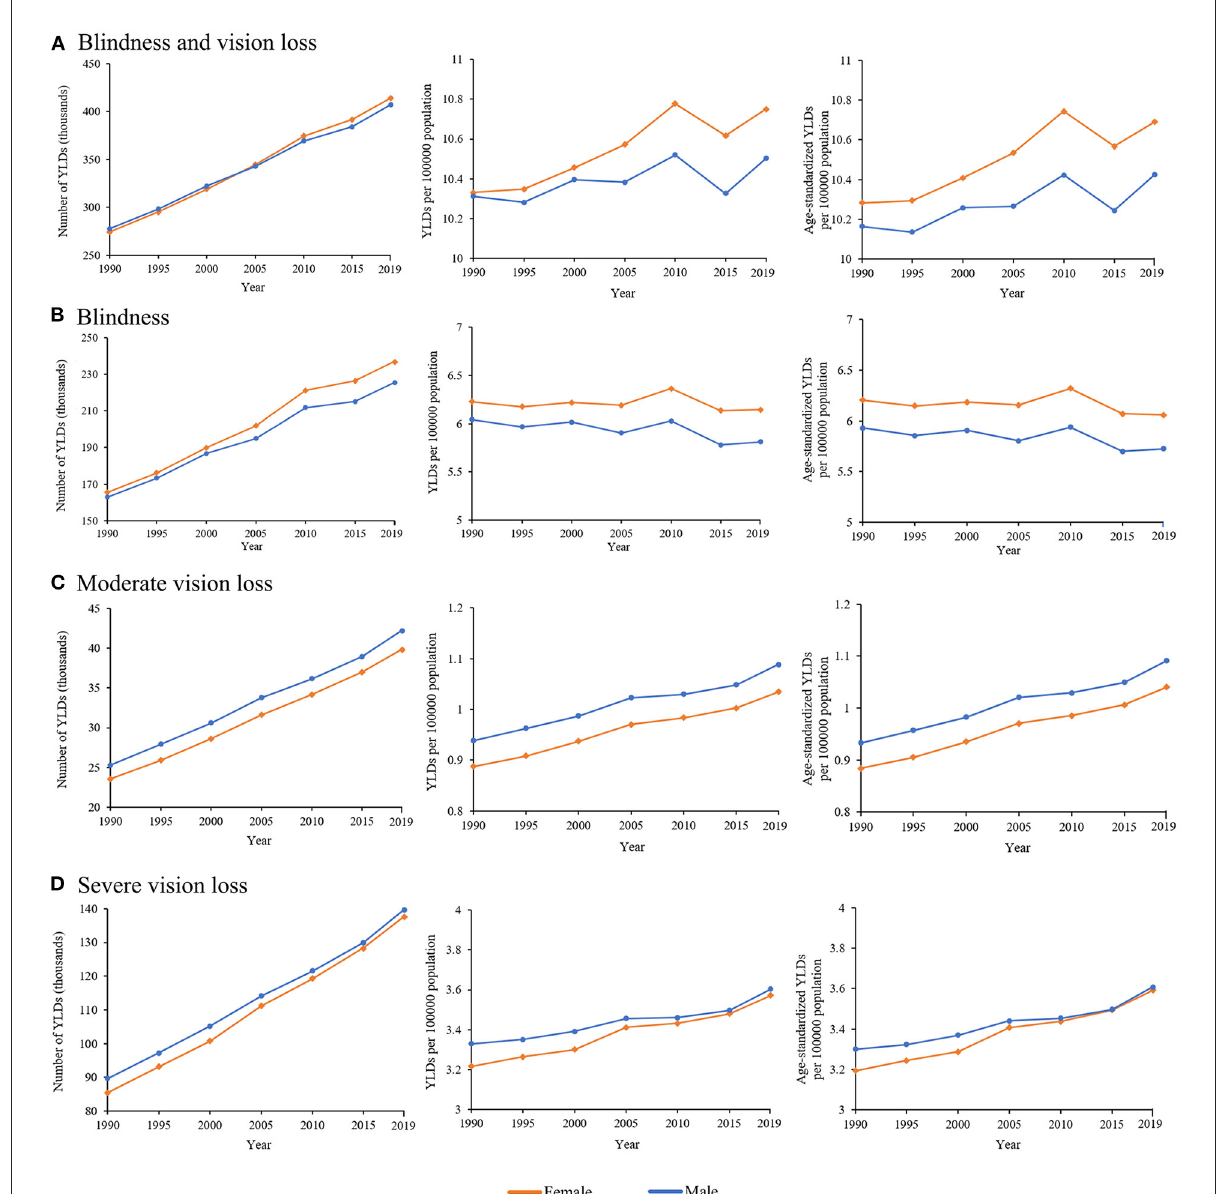
FIGURE1 Global sex-specific burden of vision impairment associated with NPB from 1990 to 2019. (A) Global burden of NPB-related blindness and vision loss, (B) NPB-related blindness, (C) NPB-related moderate vision loss, and (D) NPB-related severe vision loss in terms of YLD numbers, crude YLD rates, and age-standardized YLD rates. NPB, Neonatal preterm birth; YLDs, years lived with disability; blue line, male; orange line,